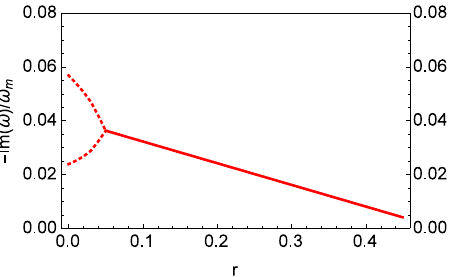
Figure 4. The imaginary parts of the solutions of d ( ω ) = 0 versus the reflection coefficient r of the beam